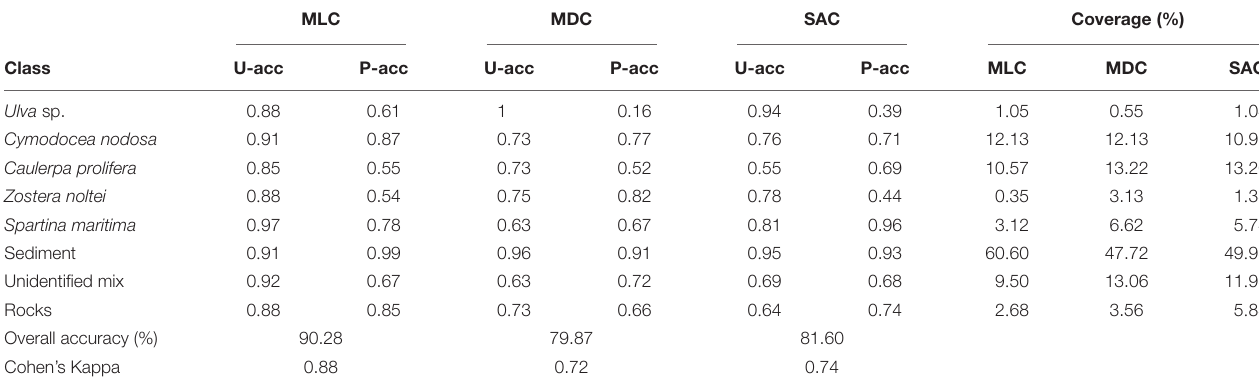
FIGURE 4 | (A) False Composite formed by the combination of bands NIR, red and green (bands 10-6-4); (B) Spectral range of macroalgal species Ulva sp. (4, purple), C. prolifera (5, blue) and seagrasses C. nodosa (3, green), Z. noltei (2, red), S. maritima (1, yellow). The reflectance has dimensionless values between 0 and 1, with 1 being 100% of the reflectance. TABLE 2 | Accuracy assessment of habitat classification with the maximum likelihood classifier (MLC), the minimum distance classifier (MDC) and the spectral angle classifier (SAC), including the accuracy of each class (user accuracy “U-acc” and producer accuracy “P-acc”), the overall accuracy (%), the Cohen’s Kappa estimate of accuracy and the coverage (%) of the classes generated. MLC